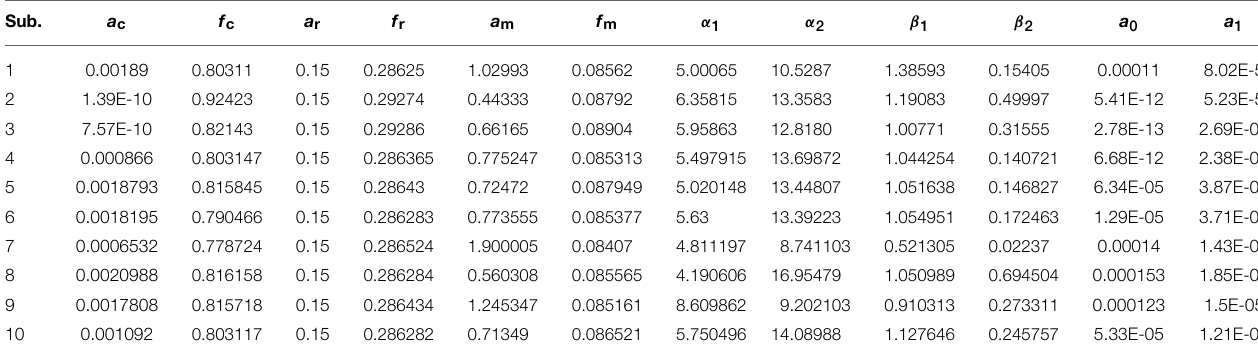
TABLE 2 | The values of free parameter estimated through proposed algorithm in most active channel of each subject.